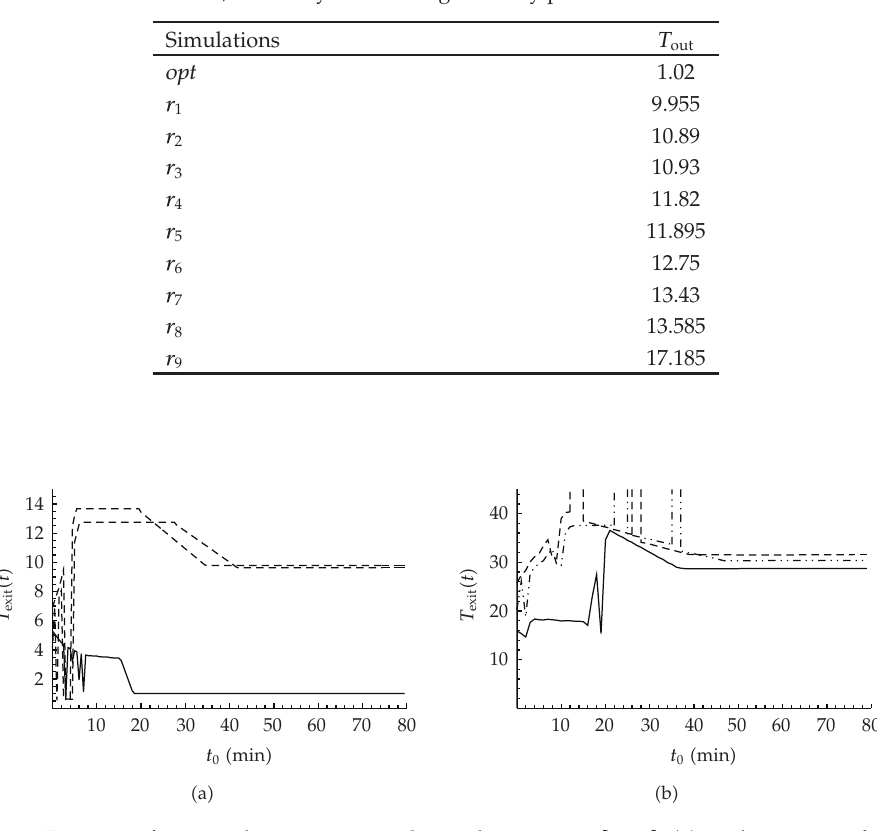
Table 2: Initial conditions, boundary data and right of way parameters for roads of the network.